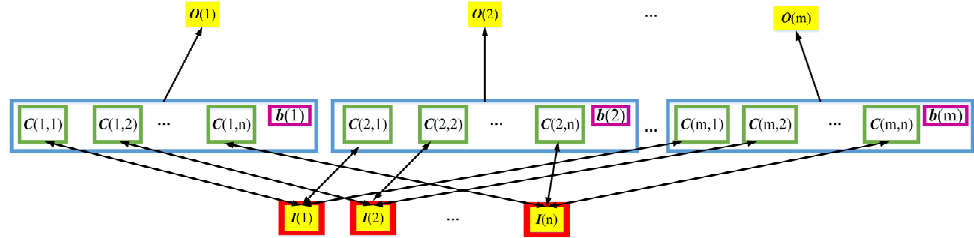
Figure 2. Schematic diagram of multi-channel convolution operations.